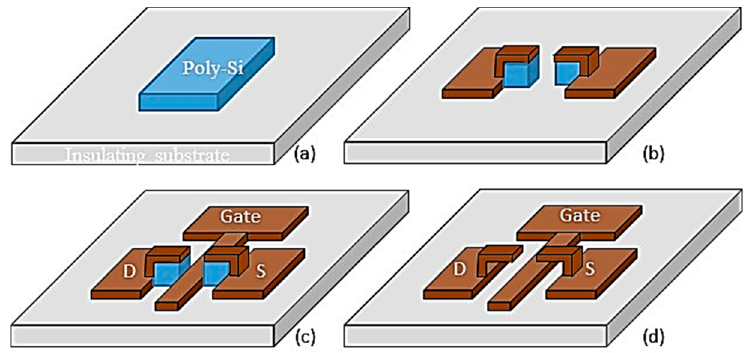
Figure 9. Schematic of the device fabrication. Polysilicon was used as sacrificial material and was preferentially etched away using XeF 2 . ( a ) The first step is to deposit and pattern the sacrificial polysilicon; ( b ) The second step is to deposit and pattern the source-drain metal (W or Cu); ( c ) The third step is to deposit and pattern the self-aligned gate metal; ( d ) The last step is to remove the polysilicon to free channel regions of the drain-source electrodes.